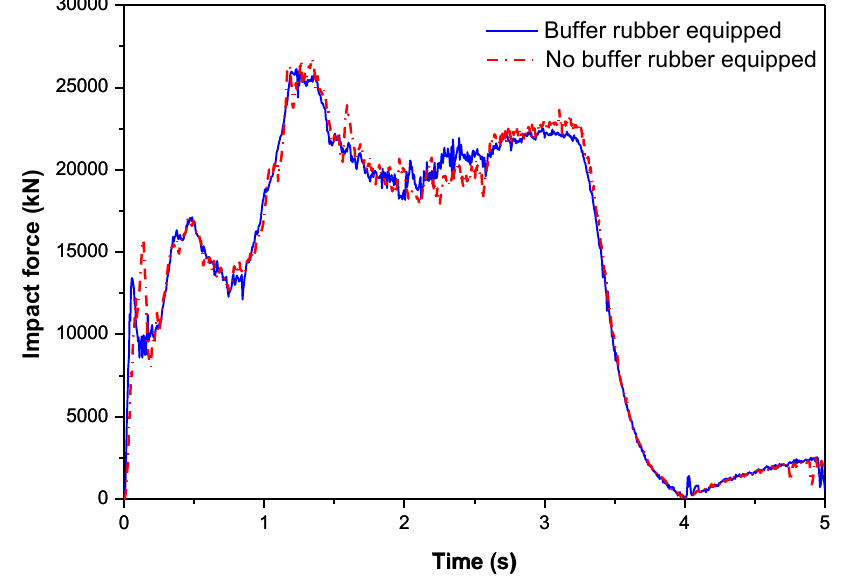
Figure 4. Reaction force histories of bridge pier with and without buffer rubber equipment.